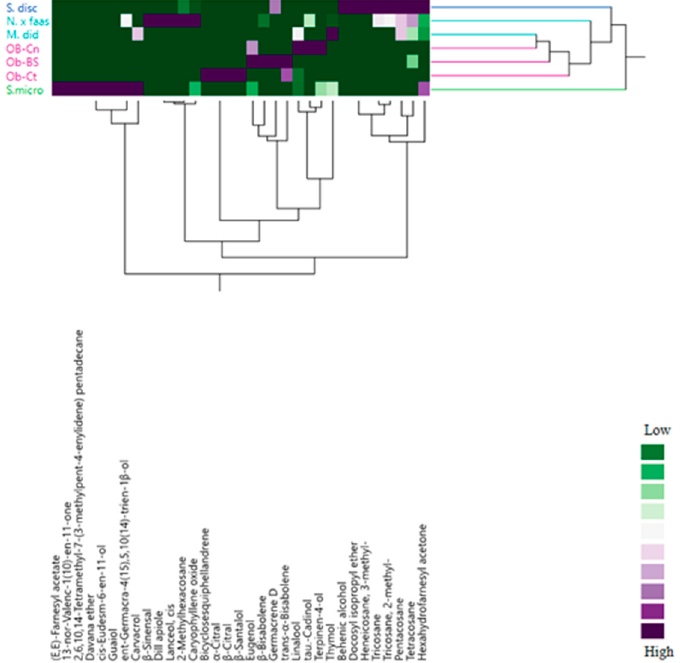
Figure 6. Dendrogram of cluster hierarchical analysis performed on EOs from the studied Lamiaceae species.